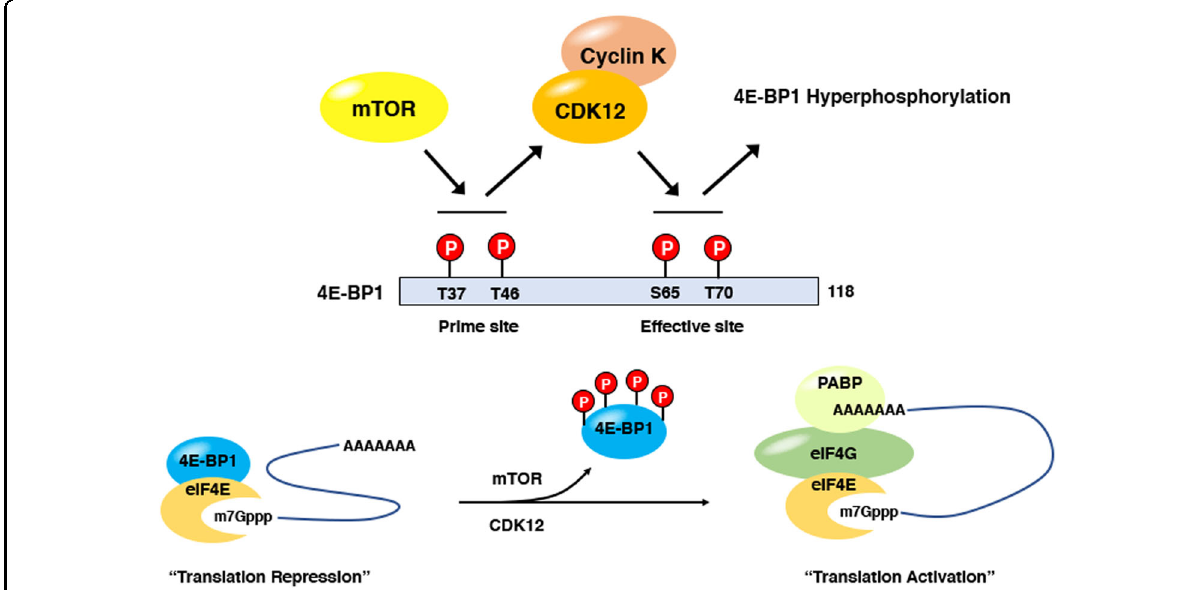
Fig. 3 A schematic diagram of the two-step phosphorylation model for 4E-BP1 for translation control by CDK12. mTOR phosphorylation (T37 and T46 site; prime site) facilitates CDK12 phosphorylation at two consensus Ser/Thr-Pro sites (S65-P and T70-P site; effective site). Full phosphorylation events in the prime and effective sites allow 4E-BP1 to be released from the eIF4E:mRNA complex, eIF4G recruitment and PABP activation for full translational activation. When 4E-BP1 is released, the active translation complex is formed through the recruitment of translation activators (eIF4G and PABP) to the eIF4E:mRNA complex shown